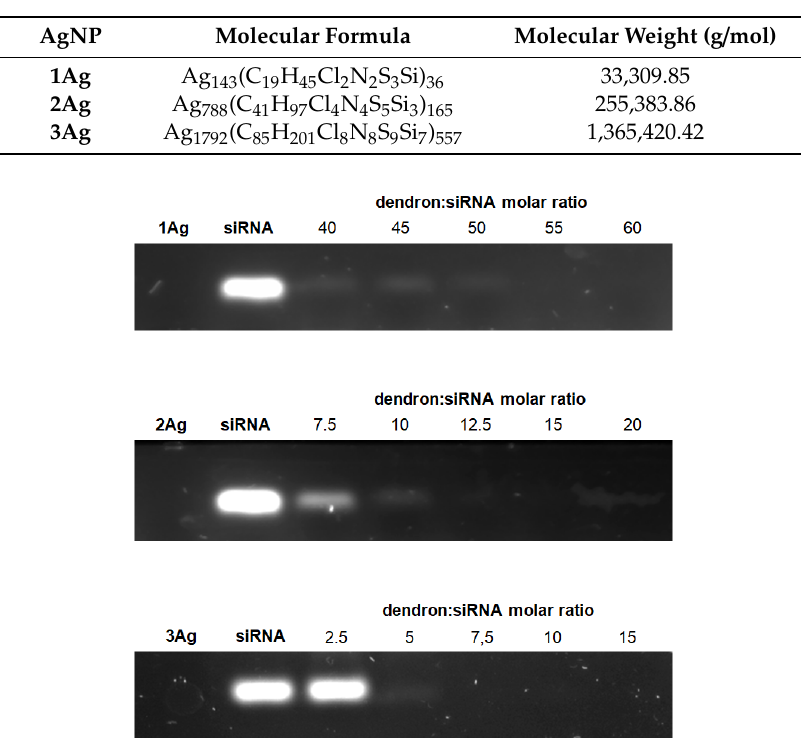
Figure 2. Electrophoresis of AgNP:siRNA complexes at varying dendron:siRNA molar ratios.